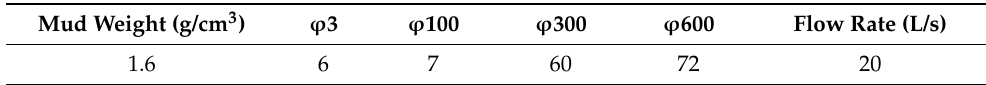
Table 3. Drilling fluid performance and drilling parameters for well